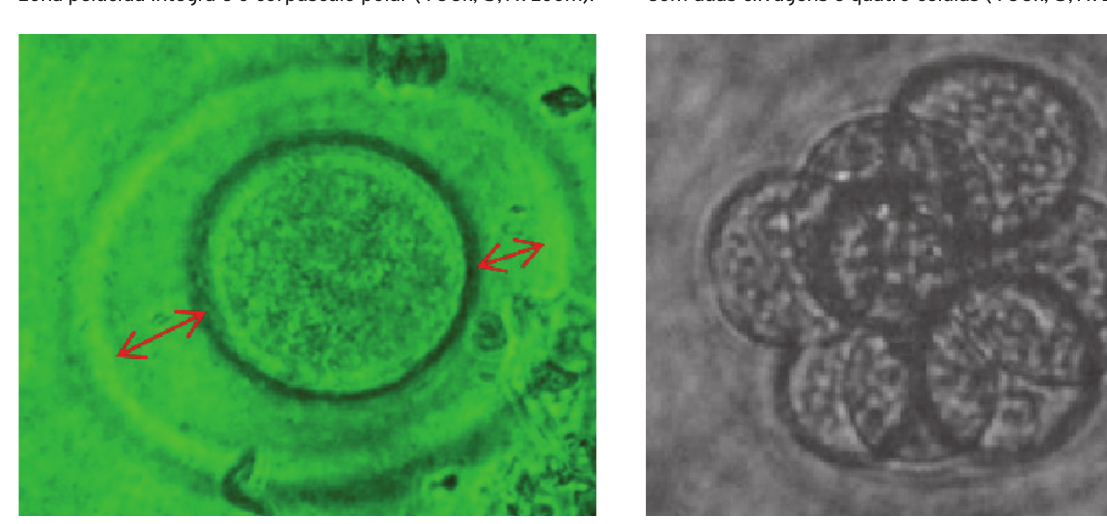
) após 72h de incubação. 4